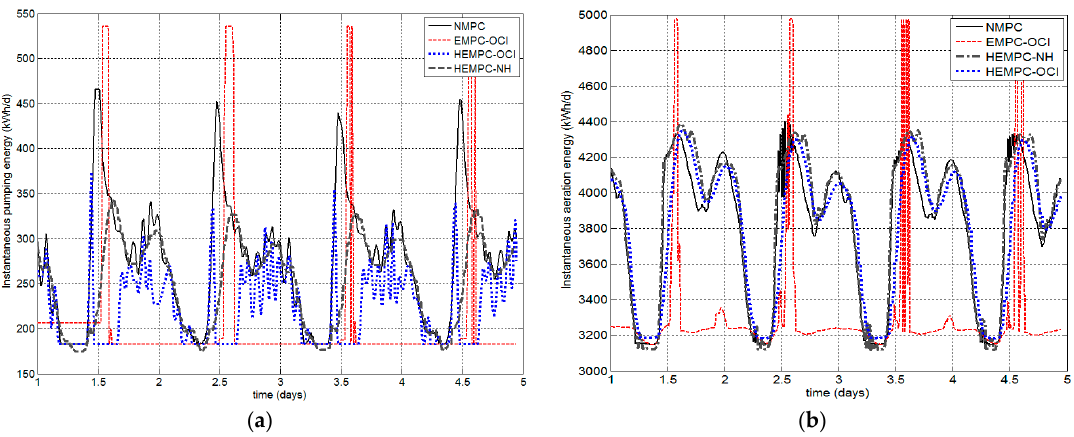
Figure 8. Instantaneous pumping ( a ) and aeration energy ( b ) for the BSM1 plant operating under selected controllers.